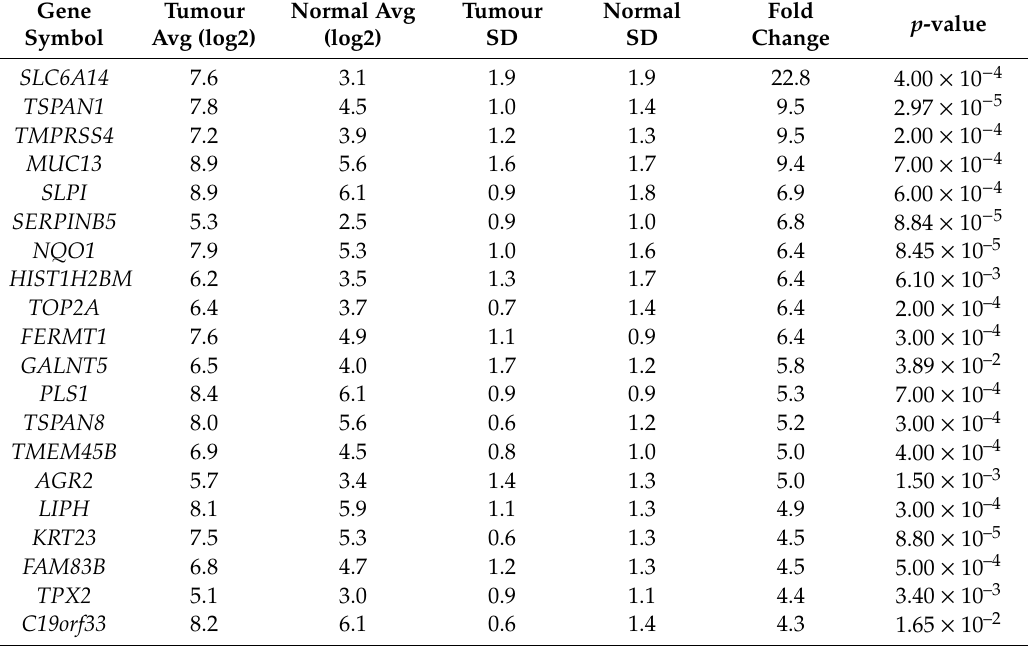
Table 6. Top 20 di ff erentially expressed genes upregulated in a comparison of tumour vs. normal samples, ordered by fold